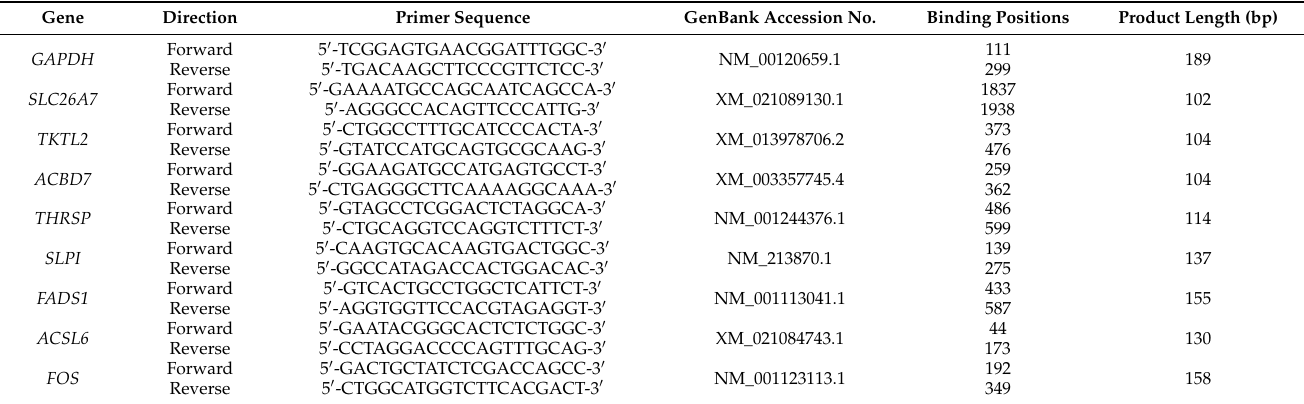
Table 1. Primer information for genes chosen for confirmation of expression using quantitative real-time PCR.